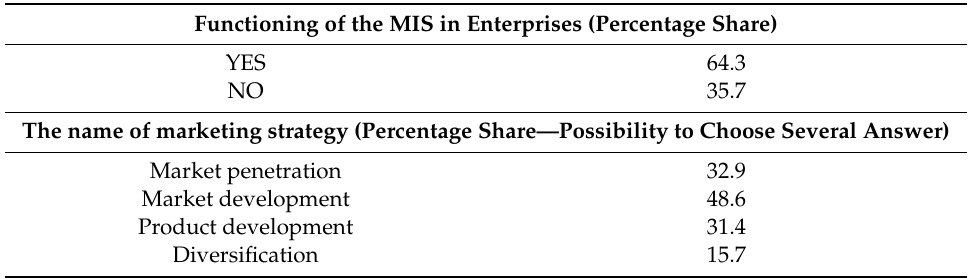
Table 4. Marketing information system vs. applied marketing strategies (n =